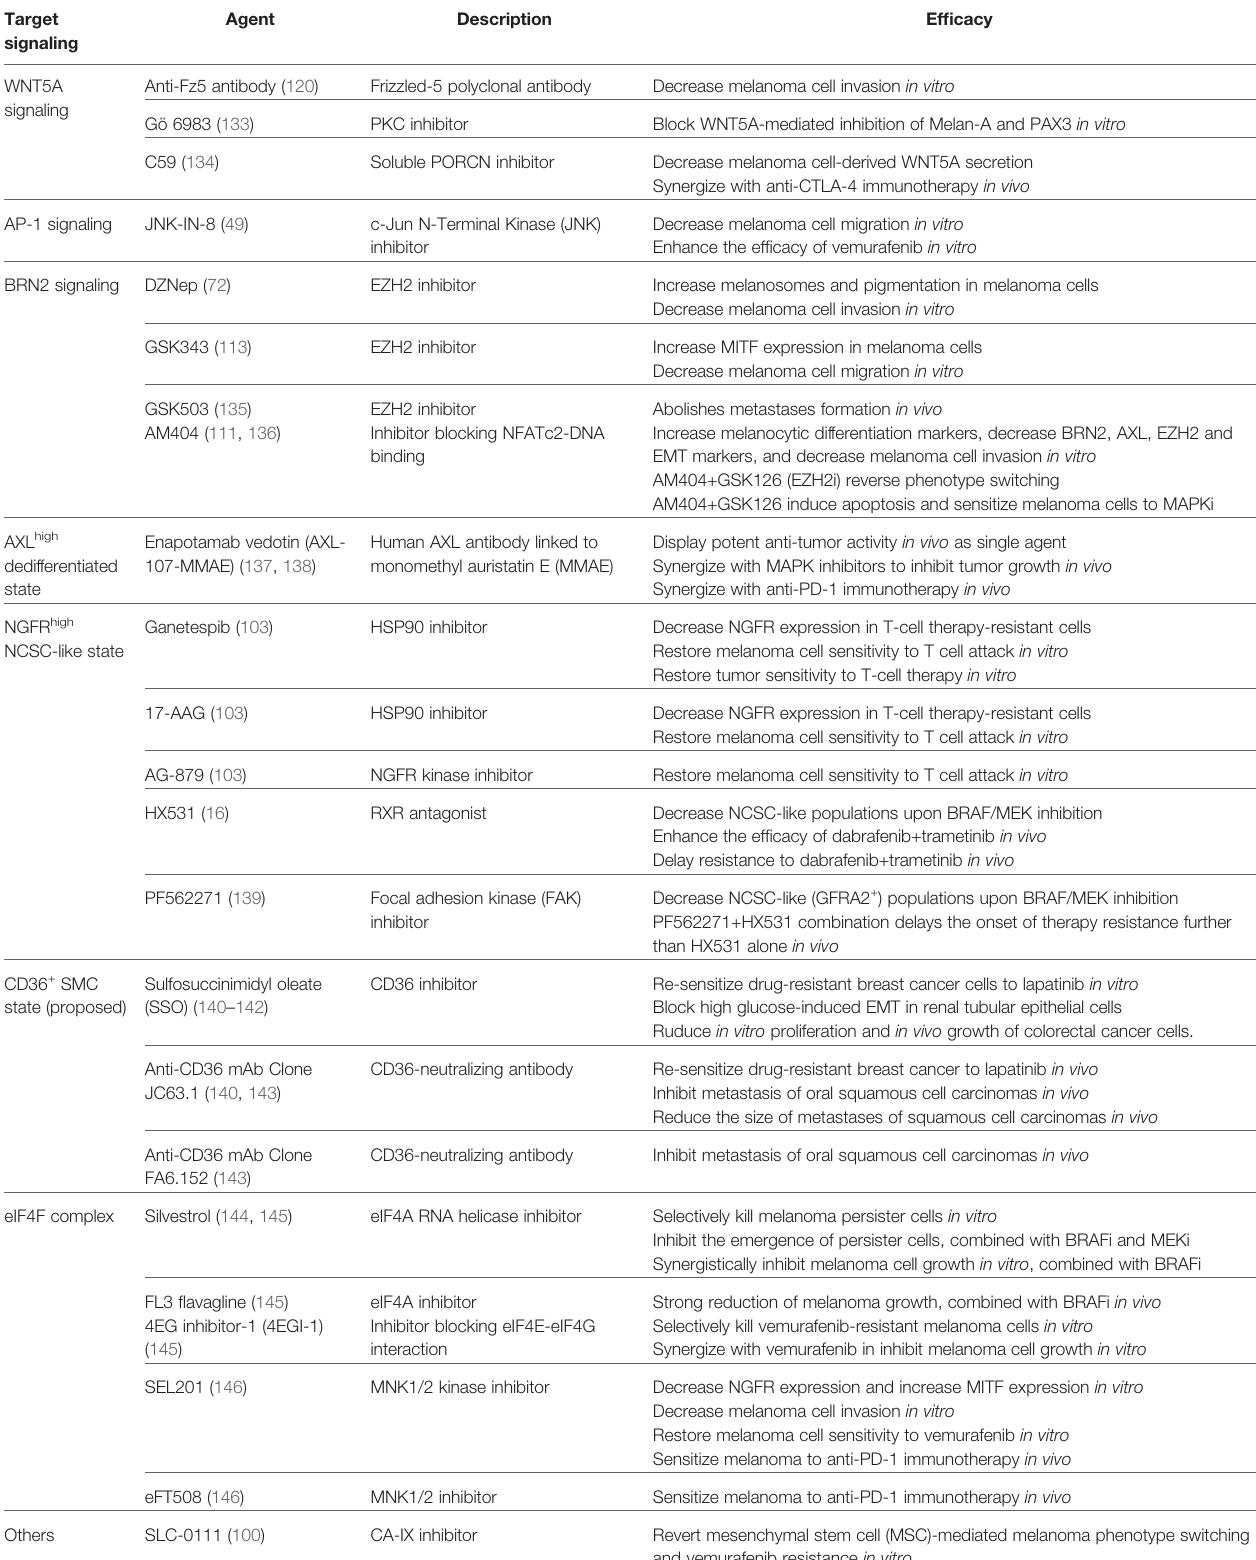
TABLE 3 | Therapeutic agents that target melanoma phenotype switching. Target